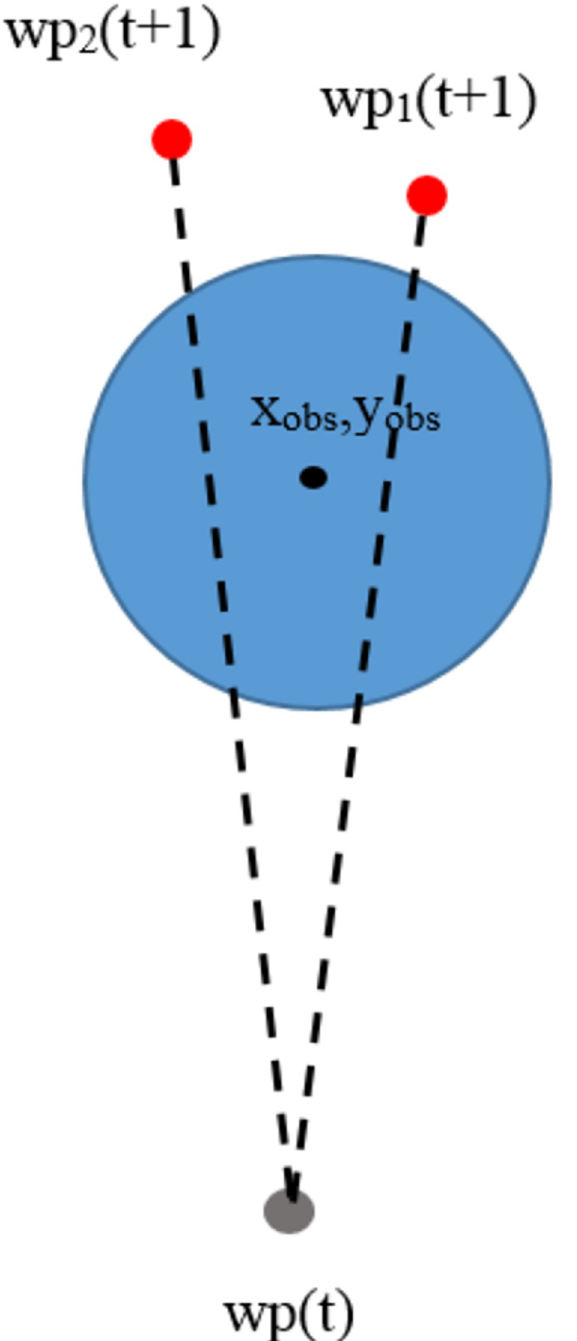
Fig 14. Infeasible waypoints when obstacles block